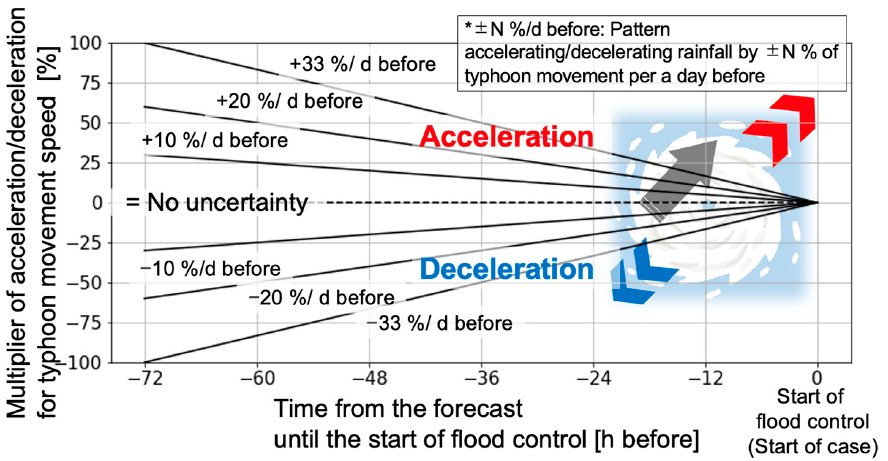
Figure 11. Forecast patterns of accelerations and decelerations to typhoon movement speeds. ± N %/d before: a pattern accelerating/decelerating rainfall by ± N % of typhoon movement per a day before.